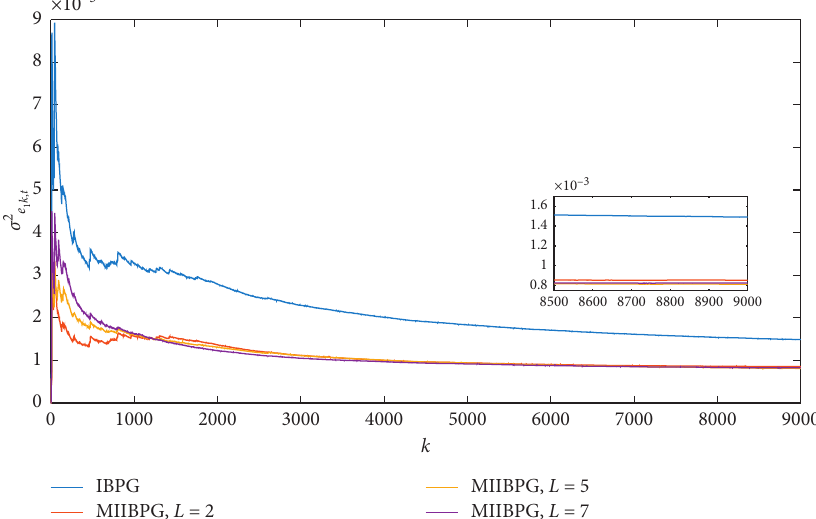
Figure 8: Evolution curves of estimation error variances for the FSOEAHW model using MIIBPG